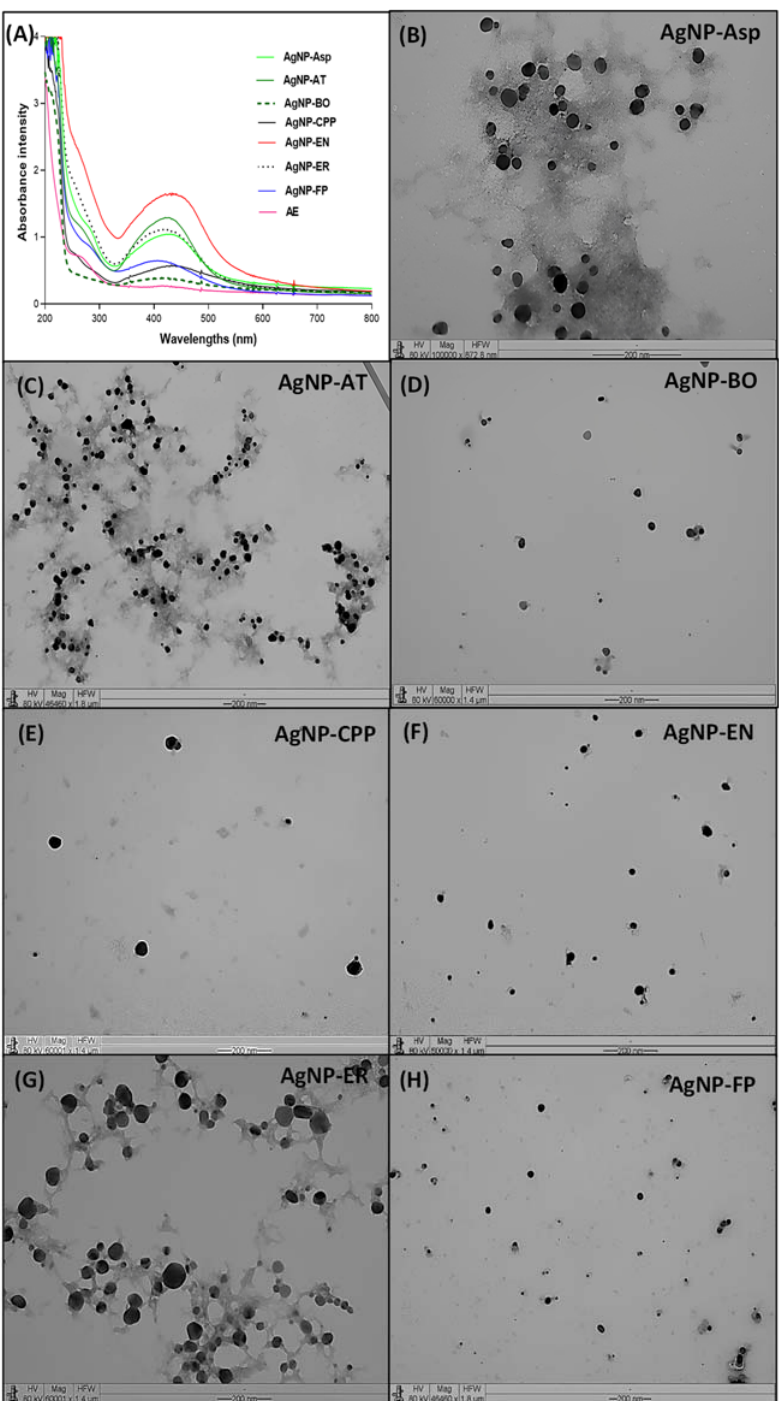
Figure 3. AgNPs characterization by ( A ) UV-Vis profile from 200 to 800 nm with presence of surface plasmon resonance around 420 nm for the AgNP-Asp, AgNP-AT, AgNP-BO, AgNP-CCP, AgNP-EN, AgNP-ER, and AgNP-FP, obtained using the extracellular cell free aqueous extract (AE) of the culture of Aspergillus spp., A. tubingensis , B. ochroleuca , C. pini-ponderosae , E. nigrum , E. rostratum , and F. proliferatum , respectively. Transmission electron microscopy for ( B ) AgNP-Asp (magnification 100,000 × ), ( C ) AgNP-AT (magnification 46,640 × ), ( D ) AgNP-BO (magnification 60,000 × ), ( E ) AgNP-CPP (magnification 60,001×), (F) AgNP-EN (magnification 50,000×), ( G ) AgNP-ER (magnification 60,001 × ), and ( H ) AgNP-FP (magnification 46,640×). The extracellular cell free aqueous extracts (AE) obtained from all fungi culture were used as control for the UV-Vis analysis and showed the same profile.